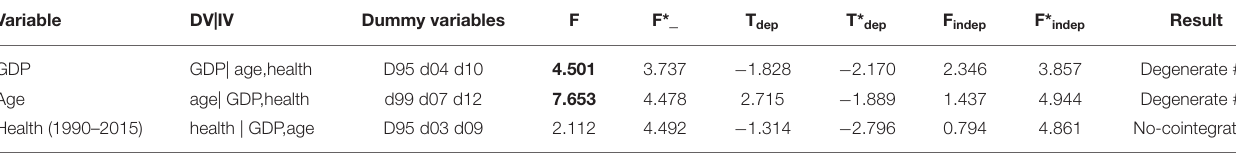
TABLE 3 | Cointegration results using Bootstrap autoregressive distributed lag (ARDL) bound test.